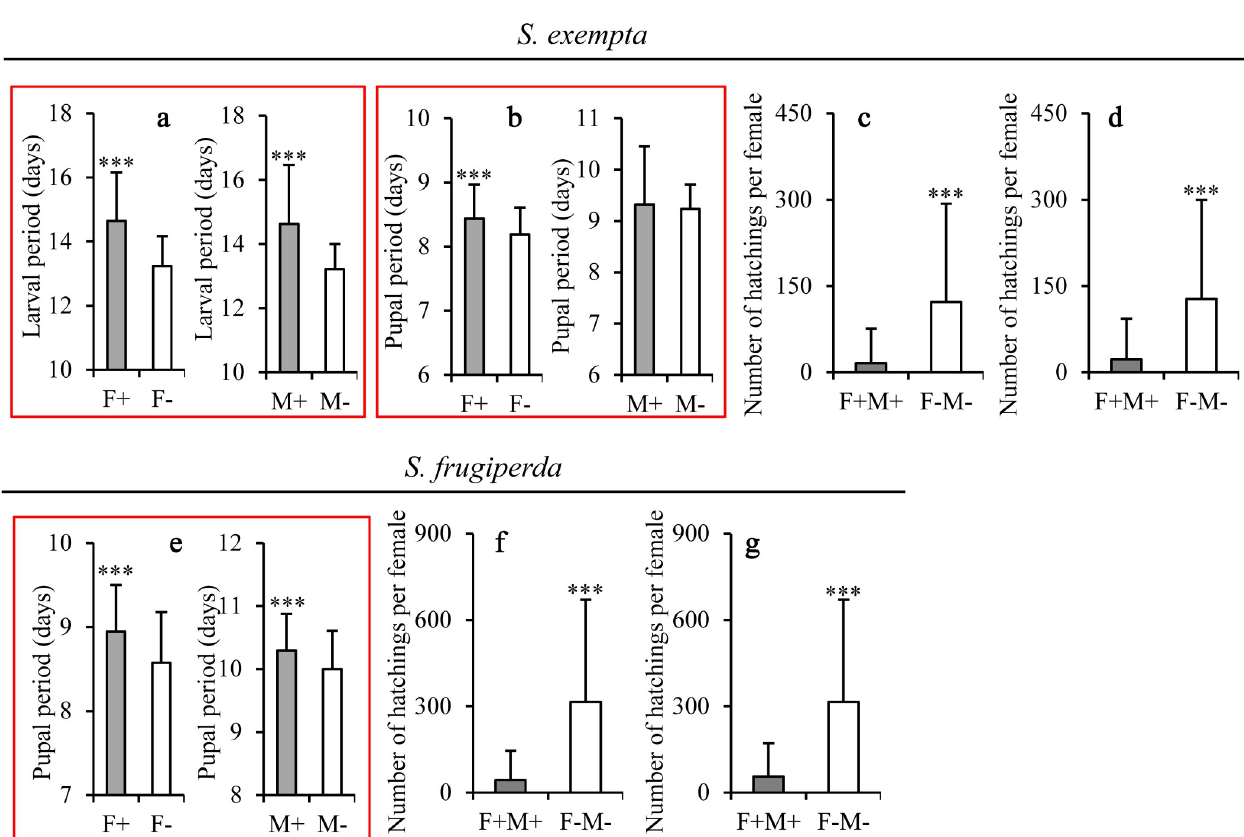
Fig 3. Life-history parameters of the partiti-like viruses-positive and -negative individuals of S . exempta and S . frugiperda . (a,b) S . exempta larval period (a) (females: t-test: t = 8.192, d.f. = 212, P < 0.0001; males: t = 6.550, d.f. = 176, P < 0.0001) and pupal period (b) (females: t = 3.729, d.f. = 212, P = 0.0002; males: t = -0.079, d.f. = 176, P = 0.94 (n: F+ = 114, F- = 100, M+ = 100, M- = 78). (c,d) Fertility (number of neonate larvae produced) of F+M+ and F-M- S . exempta pairs in all samples (c) (t = -5.031, d.f. = 74, P < 0.0001;n: F+M+ = 61, F-M- = 25) and after excluding pairs that produced no eggs (d) (t = -4.107, d.f. = 58, P = 0.00013; n: F+M+ = 43, F-M- = 24). (e) S . frugiperda pupal period (females: t = 4.82, d.f. = 225, P < 0.0001; males: t = 3.46, d.f. = 203, P < 0.0001; n: females: F+ = 110, F- = 117; males: M+ = 123, M- = 82). (f,g) Fertility (number of neonate larvae produced) of F+M+ and F-M- S . frugiperda individuals in all samples (f) (t = -4.087, d.f. = 57, P = 0.00014; n: F+M+ = 30, F-M- = 29) or after excluding pairs that produced no eggs (g) (t = -0.978, d.f. = 50, P = 0.0031; n: F+M+ = 23, F-M- = 29). Means ± SD. ��� = P < 0.001, based on t-tests at each